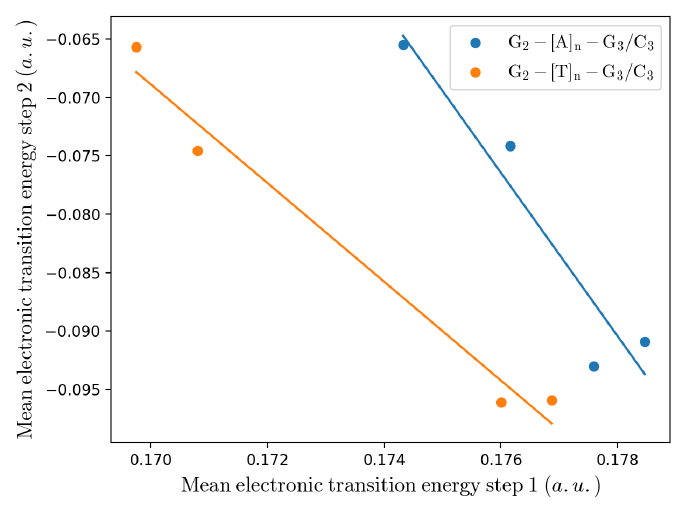
Figure 10. Mean electronic transition energy of the first reaction step of scheme I (subtracted of the corresponding unperturbed electronic transition energy), versus the mean electronic transition energy of the second reaction step of scheme I (subtracted of the corresponding unperturbed electronic transition energy). Note that larger first step mean transition energies correspond to larger bridge lengths. The solid lines are the linear regressions of the